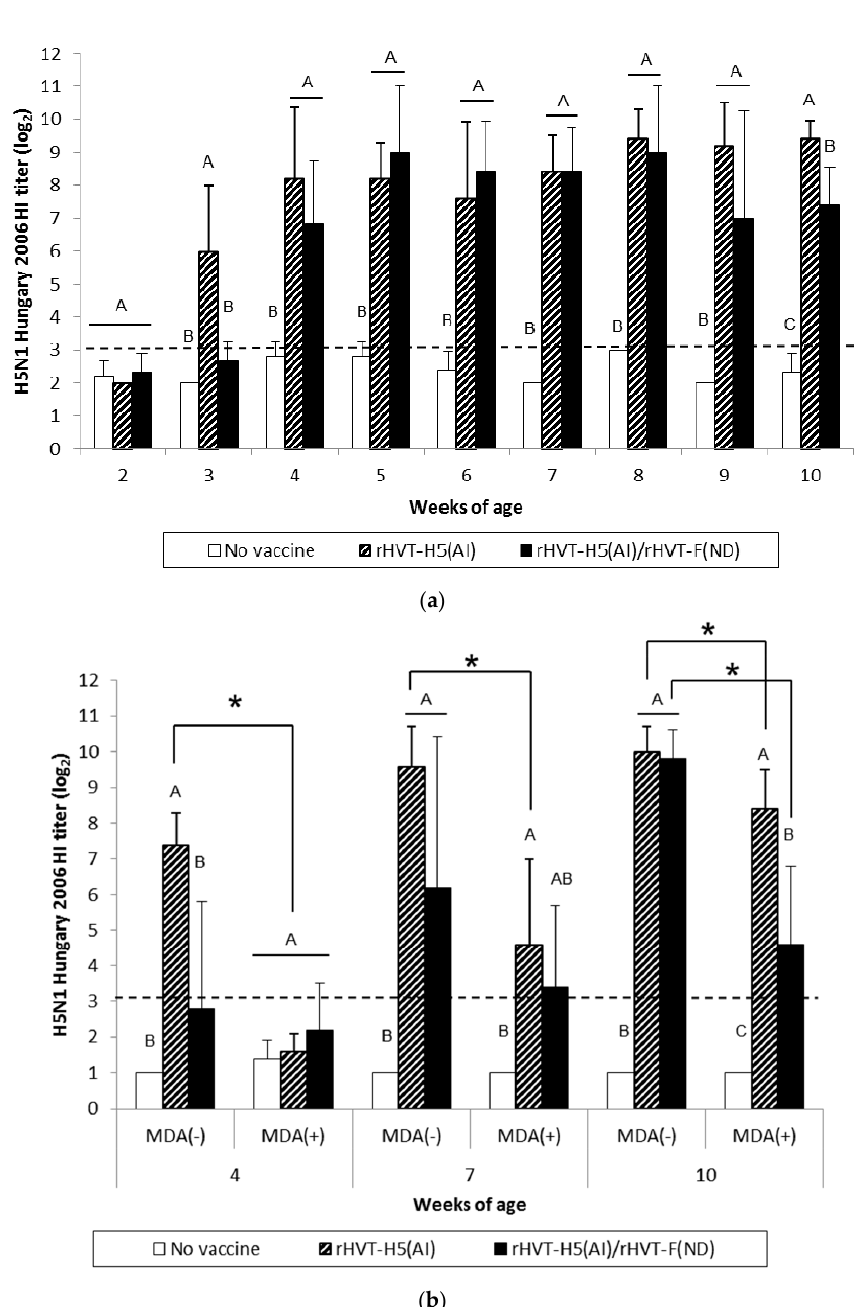
Figure 3. H5N1 Hungary 2006 HI titers in serum of WL SPF chickens ( a ) and LBL layer chickens ( b ) vaccinated at day-old (experiments I and II, respectively) with rHVT-H5(AI) or both rHVT-H5(AI)/rHVT-F(ND) vaccines. Data represent mean ± standard deviation (n = 5) of HI titers (log 2 ), which correspond to the last dilution exhibiting inhibition of 4 hemagglutination units of A/Swan/Hungary/4571/2006 AIV HA antigens. The HI geometric mean titers are expressed as reciprocal log 2 . Titers > 3 log 2 were considered positive (this threshold of positivity is indicated by the dotted line). In figure ( a ), mean ± standard deviation at time points with no common uppercase letters (A, B, C) indicates a significant difference between vaccination schedules ( p < 0.05). In figure ( b ), mean ± standard deviation at time points with no common uppercase letters (A, B, C) indicate a significant difference between vaccination schedules within the MDA group ( p < 0.05), while asterisk superscript symbol (*) indicates a significant difference between MDA(–) and MDA( + ) groups within a given vaccination schedule ( p <